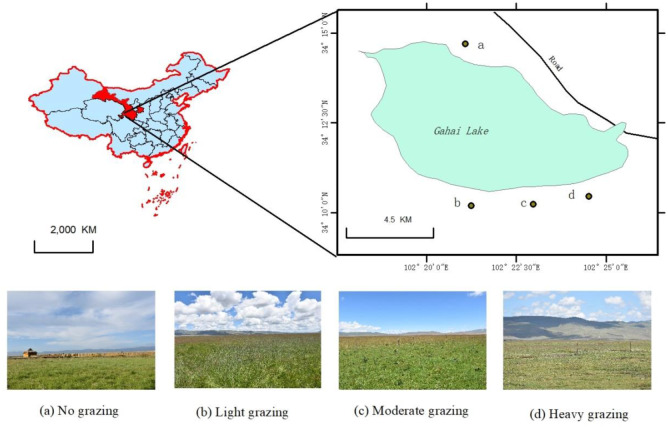
Overview of the research area.